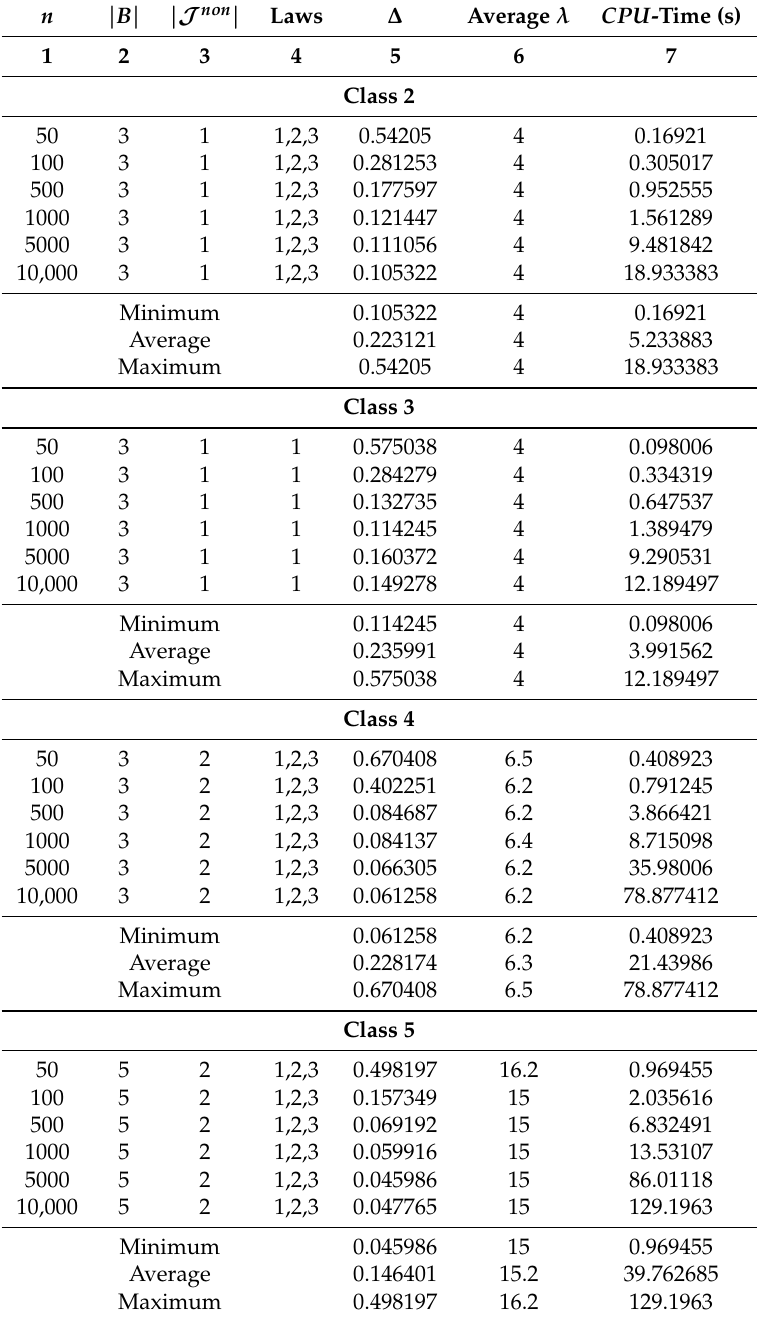
Table 3. Computational results for randomly generated instances from classes